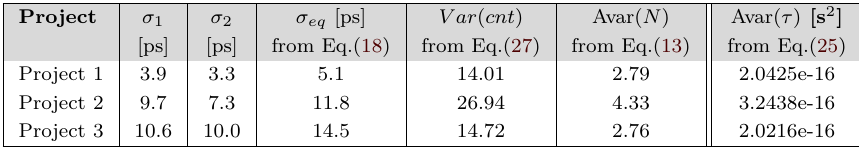
Table 4: Results of external and internal measurements of oscillator jitters in three selected projects: Columns 2 and 3 list the jitters σ 1 , σ 2 measured using the oscilloscope. Column 4 lists the equivalent jitter σ eq computed from Eq. (18). Column 5 lists the normalized variance of counter values computed from the oscilloscope using Eq. (27). Column 6 lists the Allan variance estimate computed inside the device using Eq. (13).